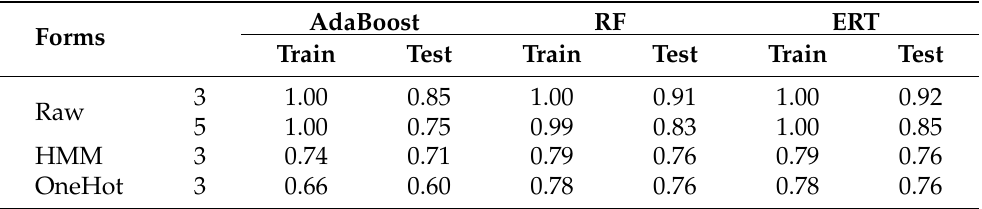
Table 4. The A cc of models for the torque prediction in different forms of input